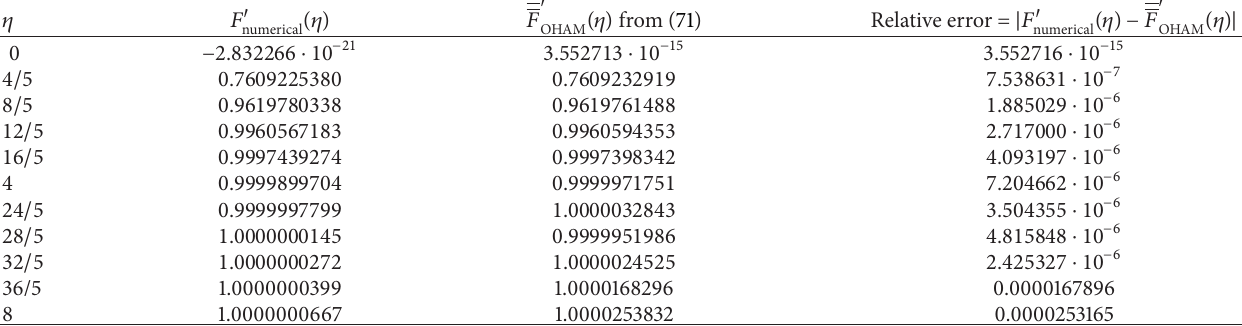
󸀠 (𝜂) obtained from (71) and numerical results for 𝛽 = 1.6 .